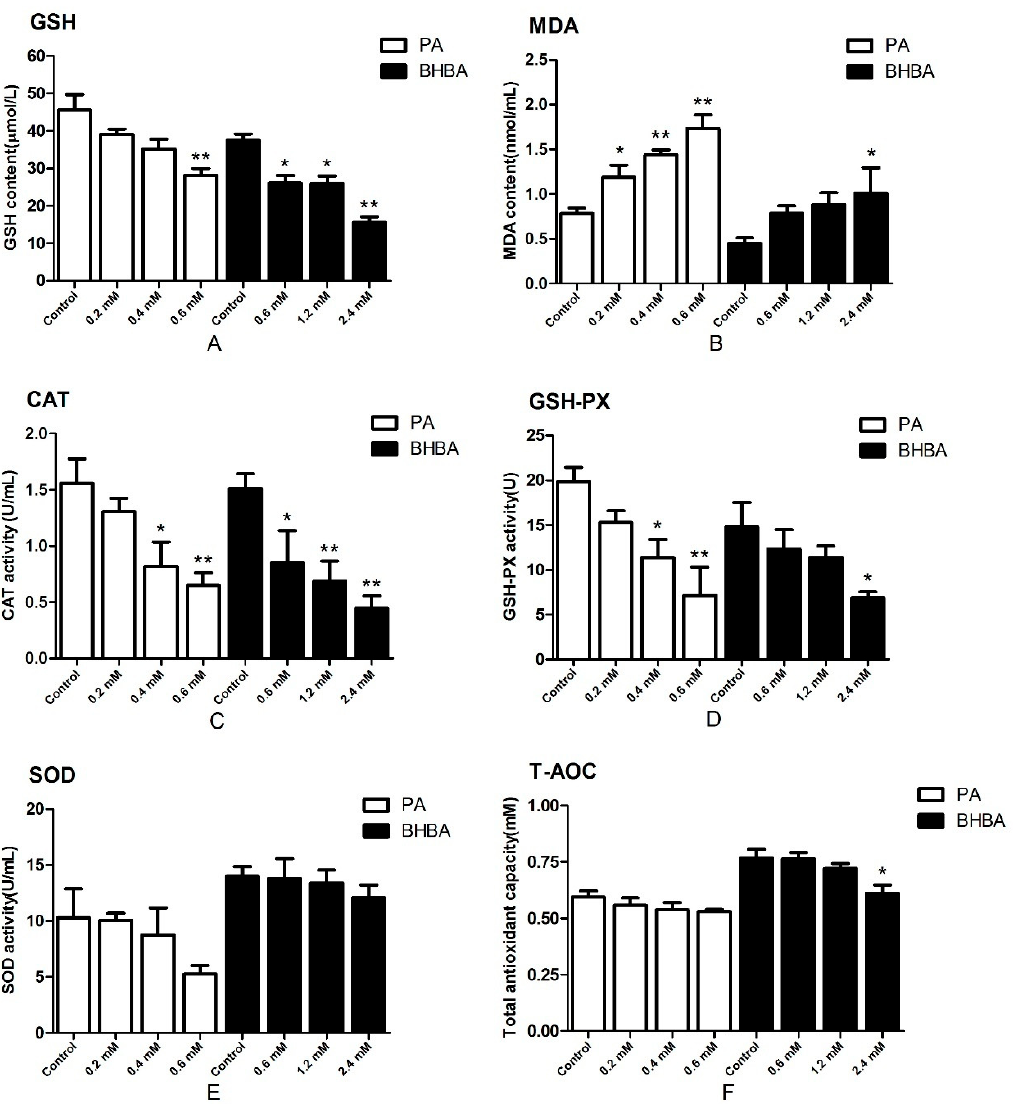
Figure 2. Effects of PA and BHBA on oxidative status. Contents of ( A ) glutathione (GSH) and ( B ) malondialdehyde (MDA), and activities of ( C ) catalase (CAT), ( D ) glutathione peroxidase (GSH-PX), ( E ) superoxide dismutase (SOD), and ( F ) total antioxidant capacity (T-AOC) in BEND cells treated with PA (0.2, 0.4, or 0.6 mM) or BHBA (0.6, 1.2, or 2.4 mM) for 24 h. Data are expressed as the mean ± SEM. * P < 0.05, ** P < 0.01 vs. the control.